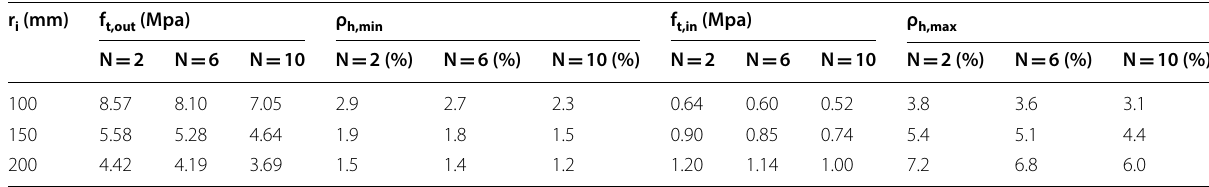
Table 2 Circular reinforcement